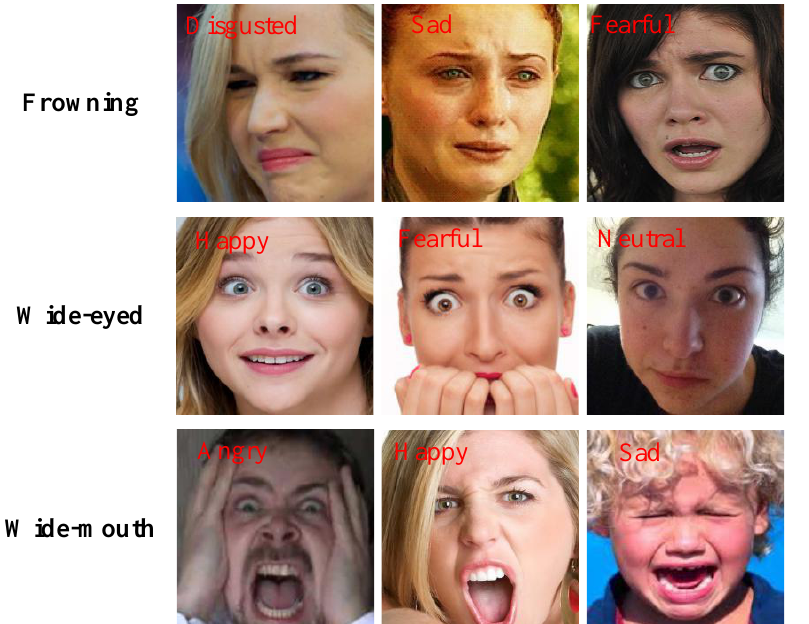
Figure 3. Different expressions have the same facial movements. The black font on the left indicates the similar features in the images. The upper left red font in each face image indicates the expression category of the